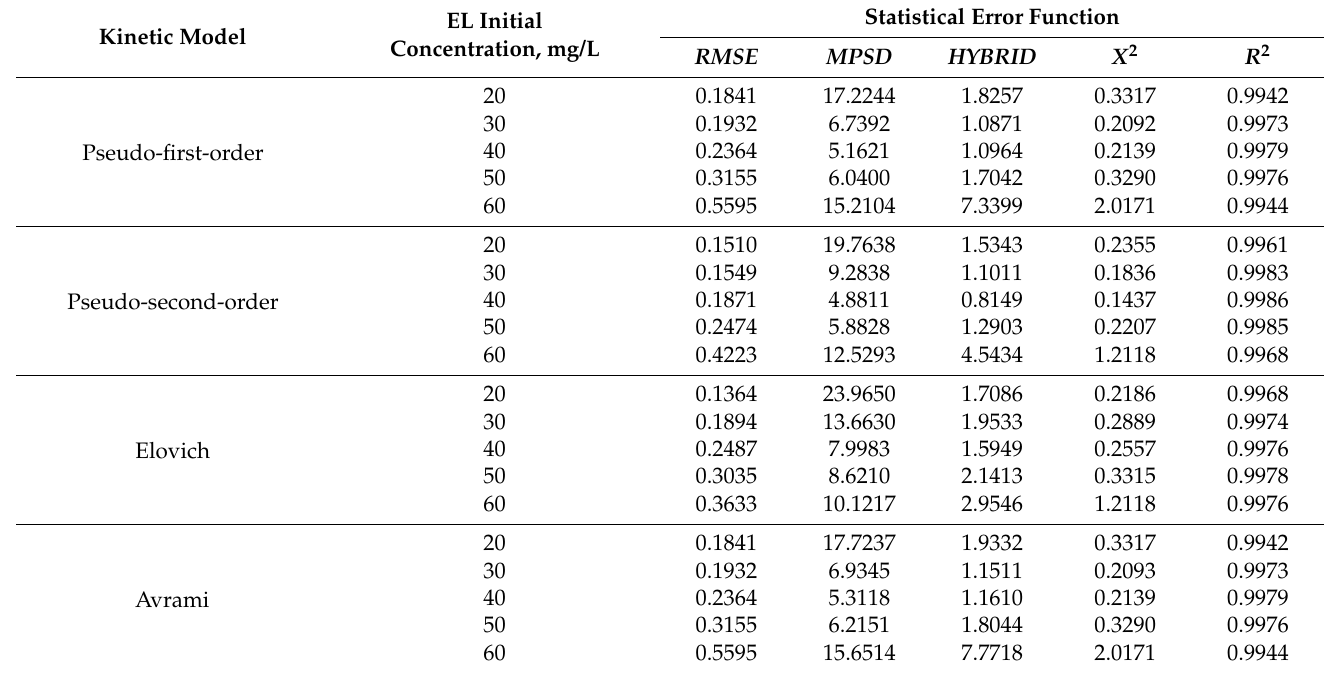
Table 6. Statistical error functions of estimated kinetic nonlinear models for the biosorption process conducted on SPA 5% biosorbent.